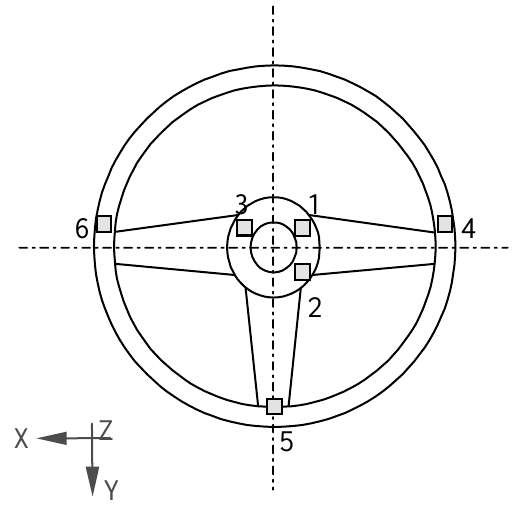
Fig. 7. Schematic of the steering wheel showing accelerometer positions and reference